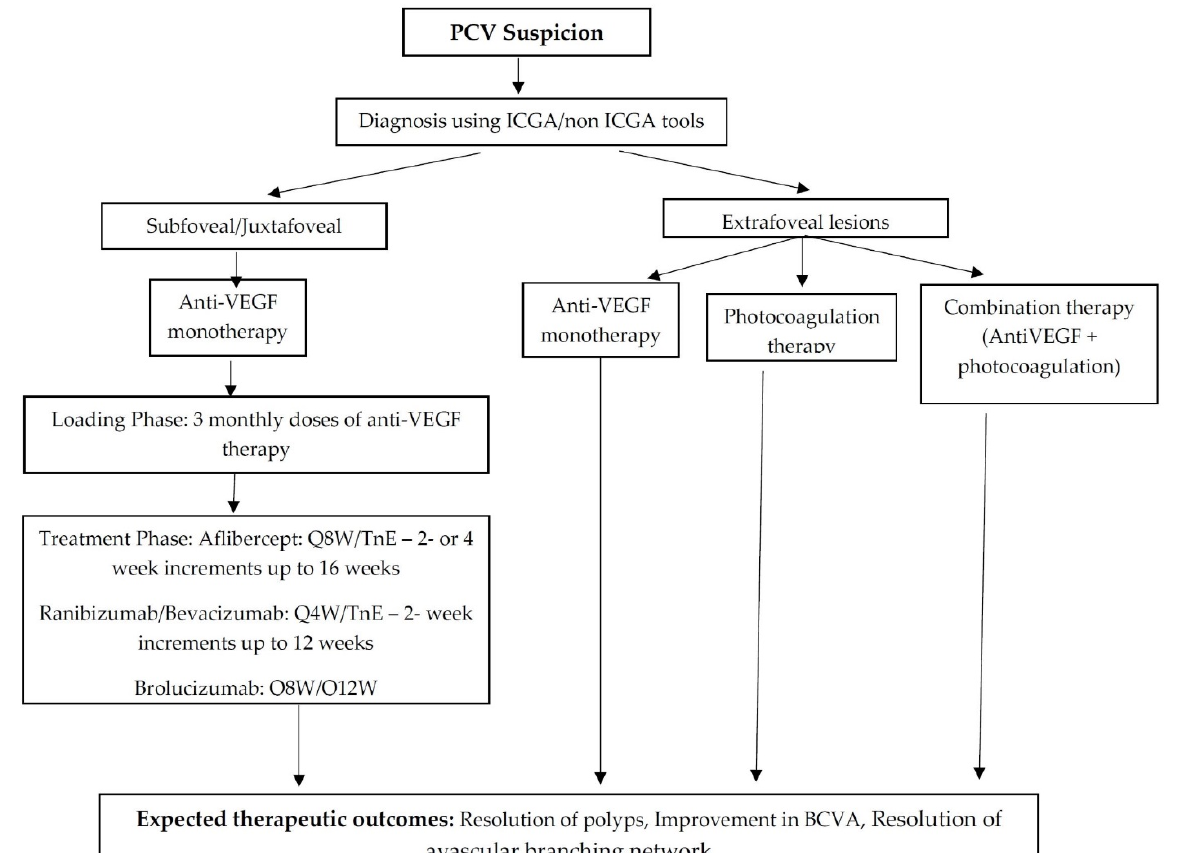
Figure 5. Proposed treatment algorithm for PCV based on latest evidence tailored for Vietnam.